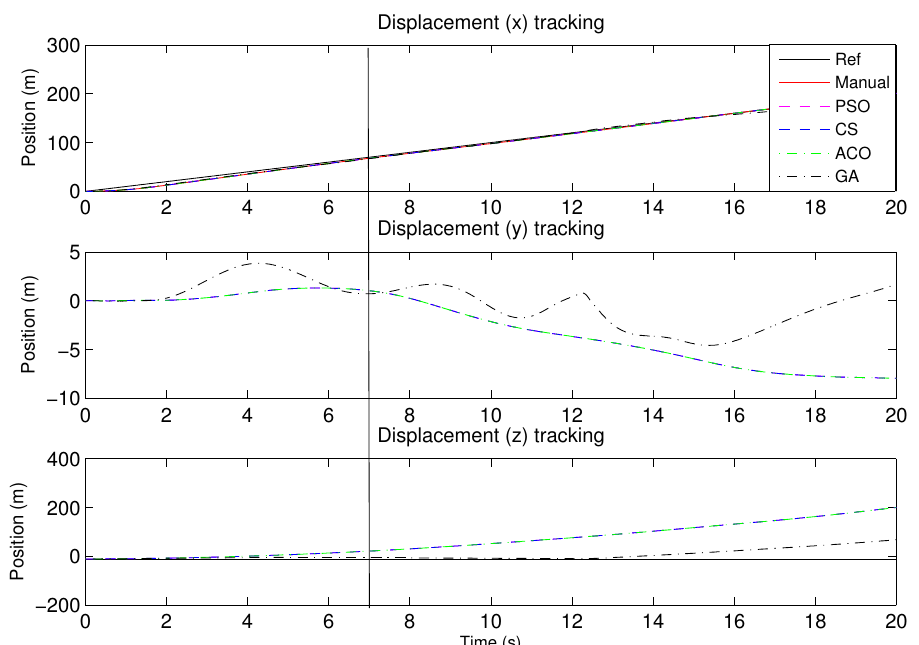
Figure 16. The position of the rotorcraft in response to starboard gust disturbance at 10